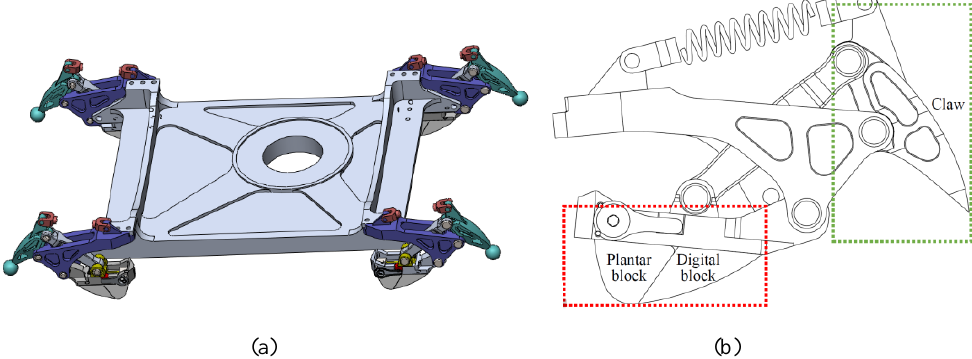
Figure 3. Humanoid robot foot and the bionic mechanism: ( a ). appearance of the foot with the bionic mechanism; ( b ) details of the bionic